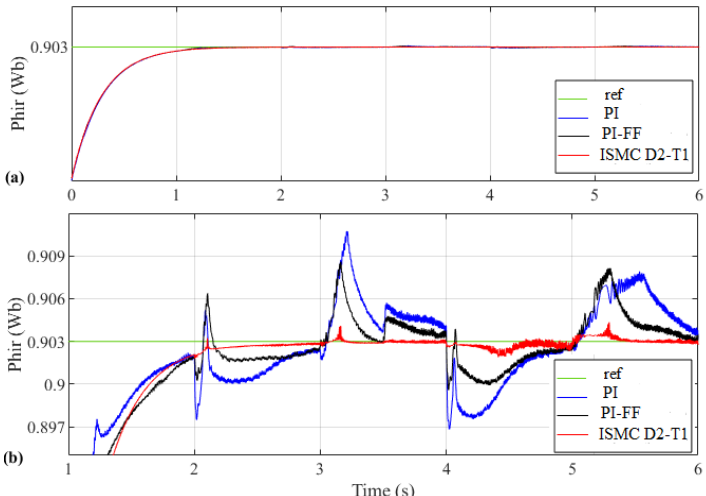
Figure 9. Experimental tests for flux performance comparison between the enhanced ISMC D2 design and the PI regulators using 600-rpm reference speed: ( a ) Rotor flux and ( b ) Magnification of the rotor